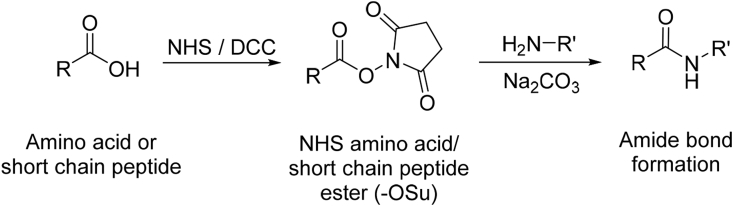
Synthesis of N-hydroxysuccinimide (NHS) amino acid/peptide ester utilized in the synthesis of peptides 13–20. R = -CHR1-NH2/short peptide, R’ = -CHR2-COOH, R1/R2 = side chains.